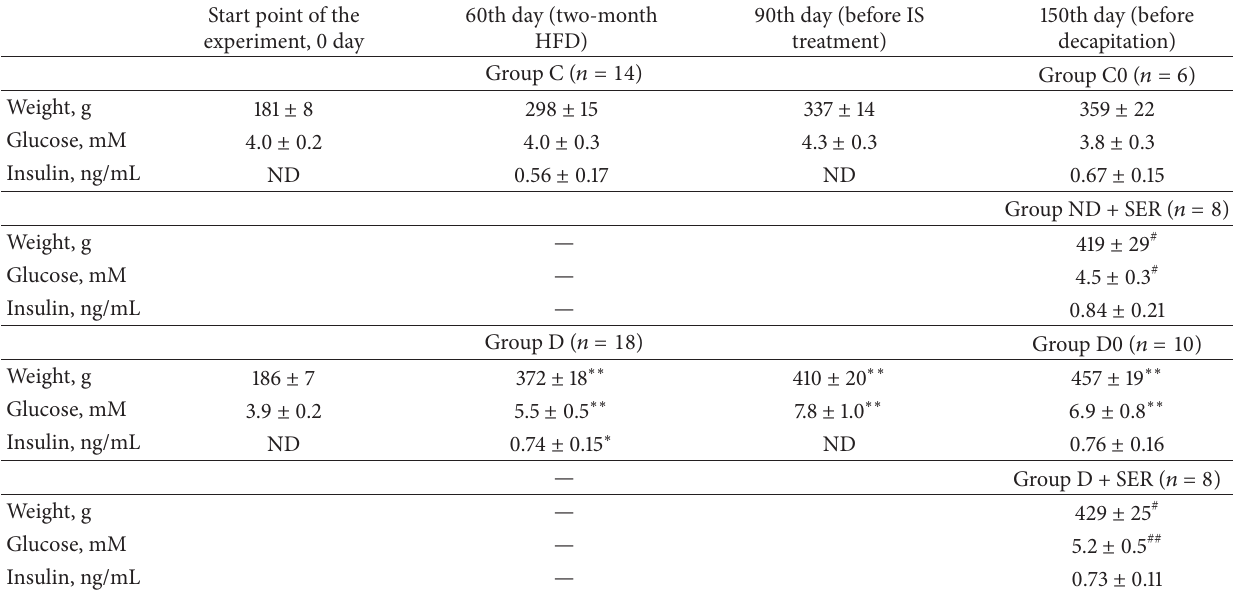
Table 1: The body weight and the plasma level of fasting glucose and insulin in control and diabetic rats and the influence of the treatment with